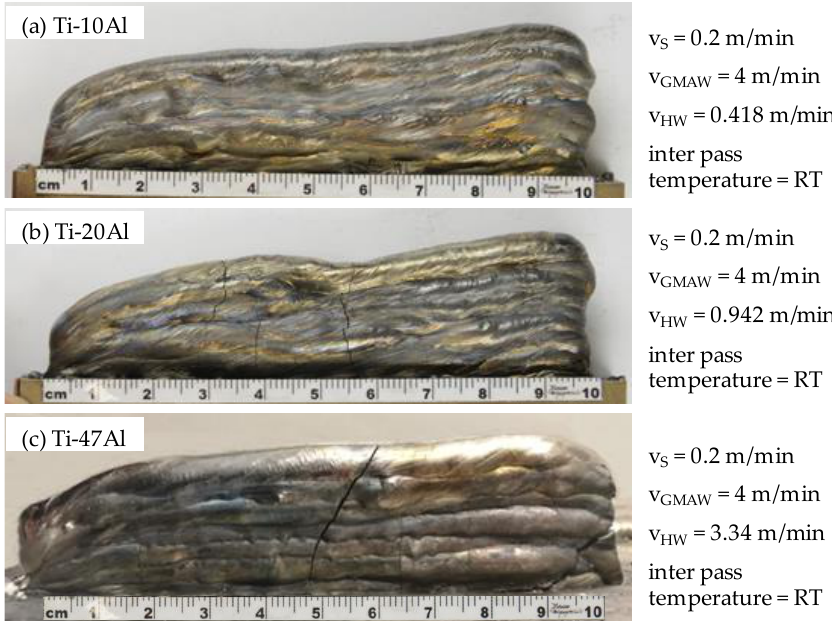
Figure 3. Wire arc additive manufacturing of wall structures of Ti – Al with differing content of Al ( a ) 10 at%, ( b ) 20 at%, ( c ) 47 at% and resulting cold cracks ( b ), ( c ). RT = room temperature.